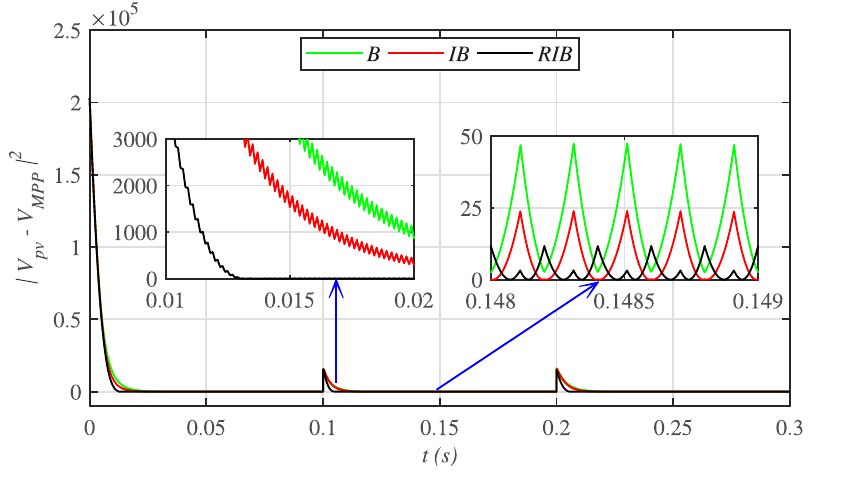
Fig 13. PV array output voltage error comparison under case 1.